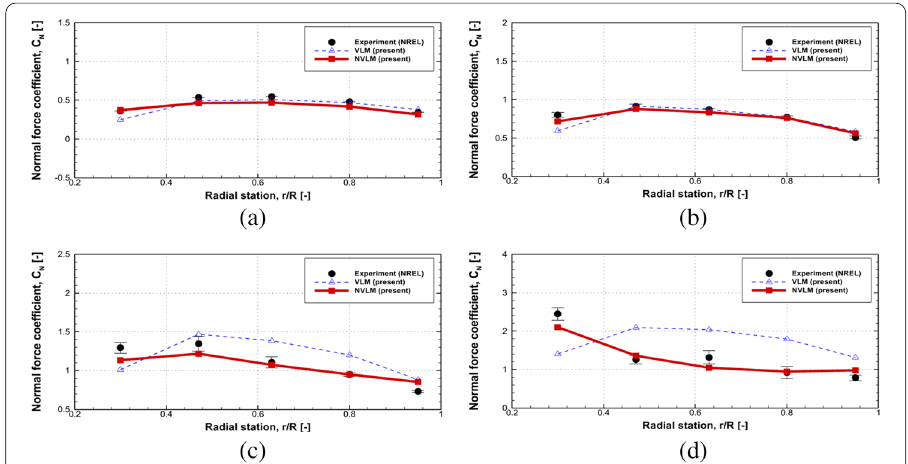
Fig. 10 Comparison of normal force coefficients depending on wind speed: ( a ) 5 m/s, ( b ) 7 m/s, ( c ) 10 m/s, and ( d ) 15 m/s